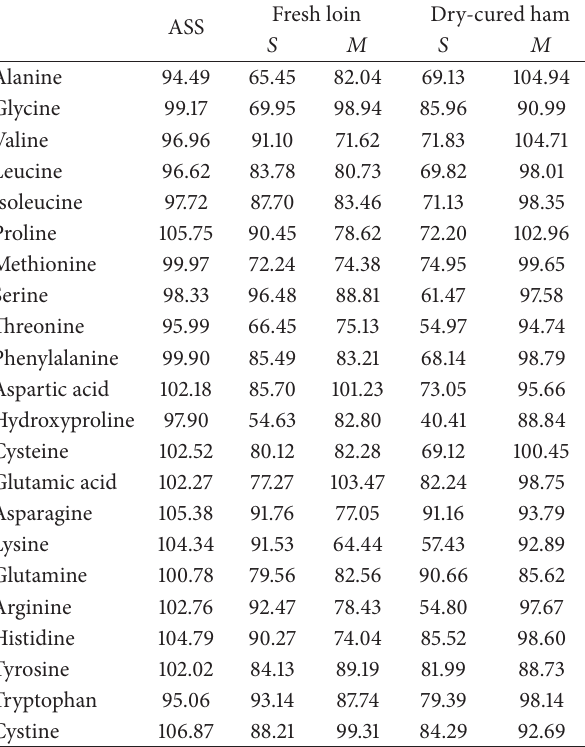
Table 5: Recoveries (%) in aqueous standard solution (ASS) and in spiked samples extracted by using stomacher ( 𝑆 ) and mixer mil ( 𝑀